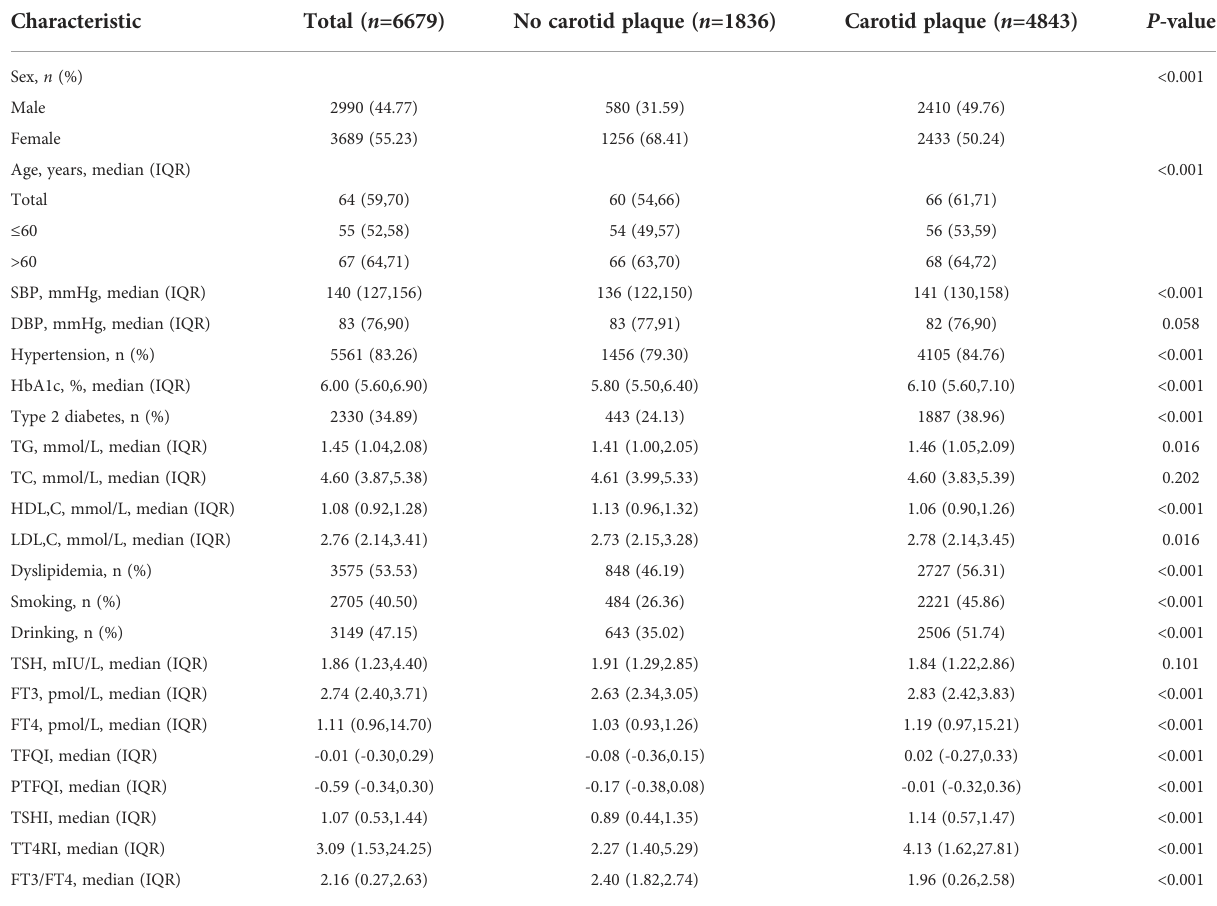
TABLE 1 General characteristics of study participants.